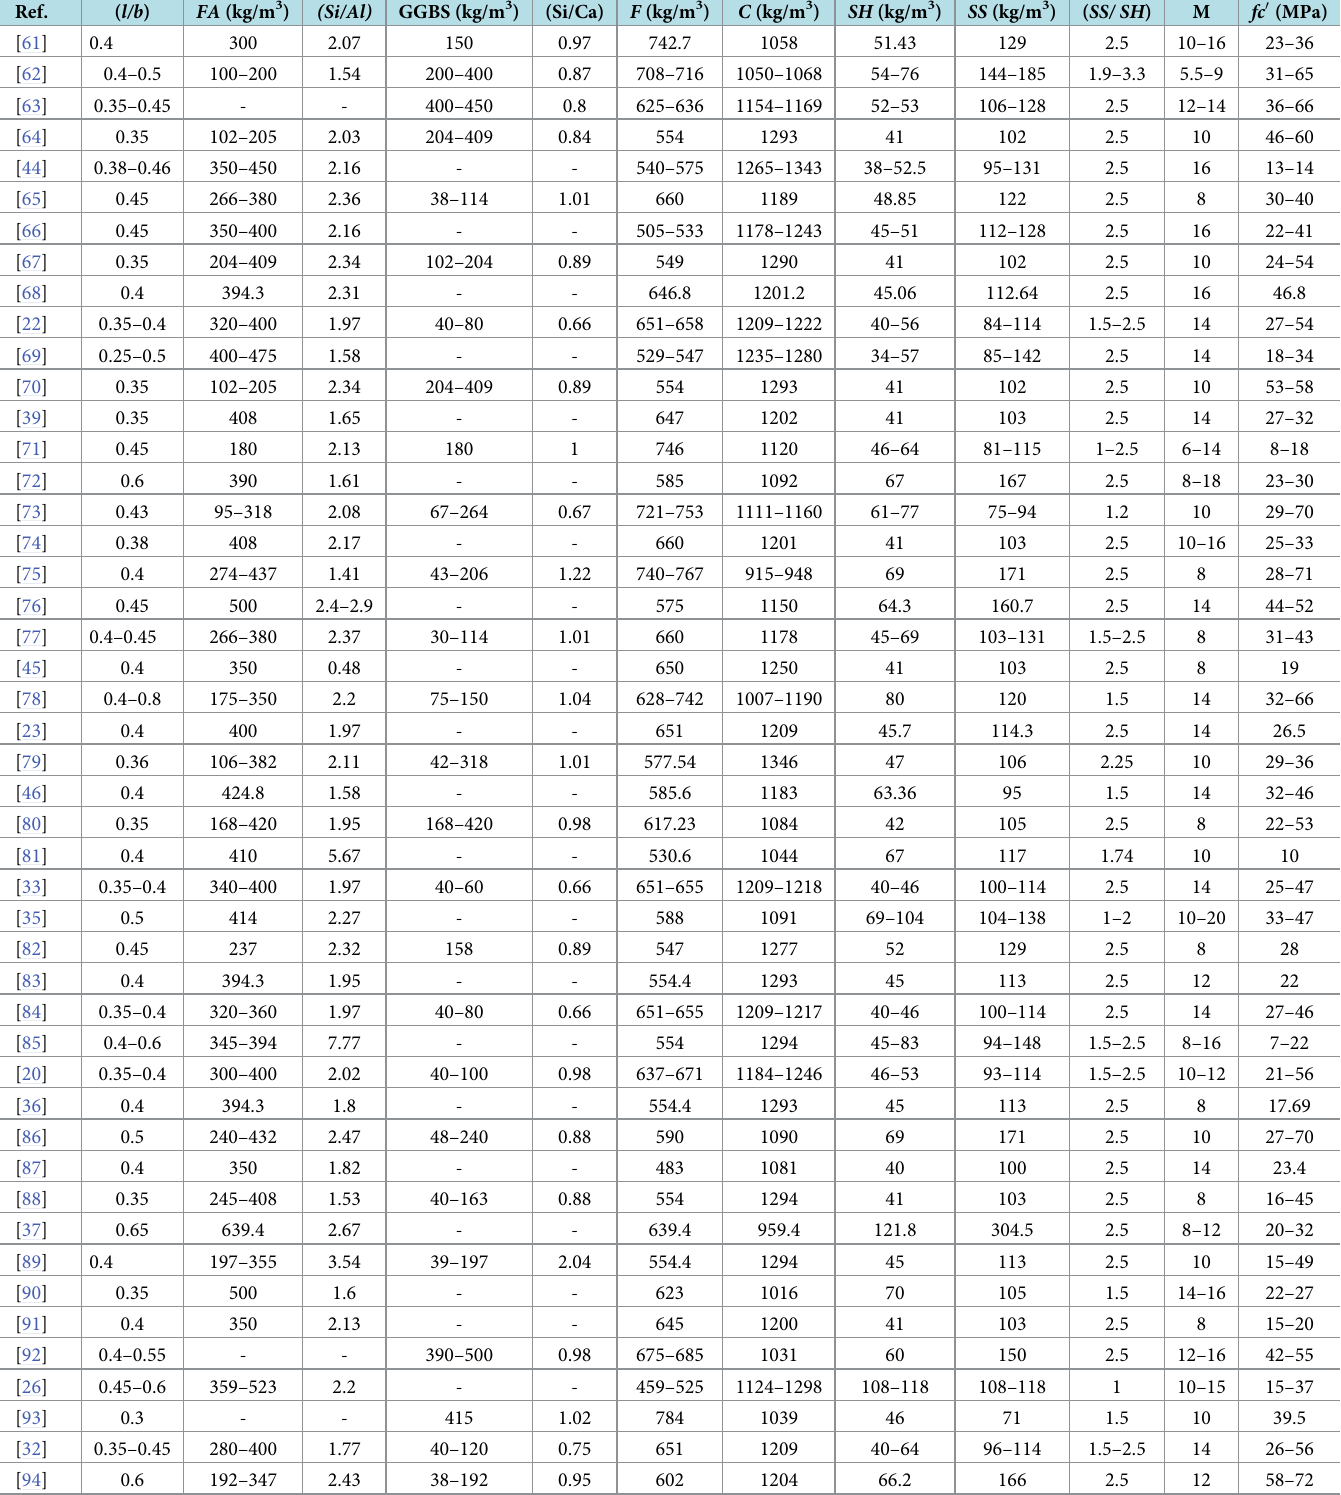
Table 1. Summary of different GGBS/FA-GPC mixes.